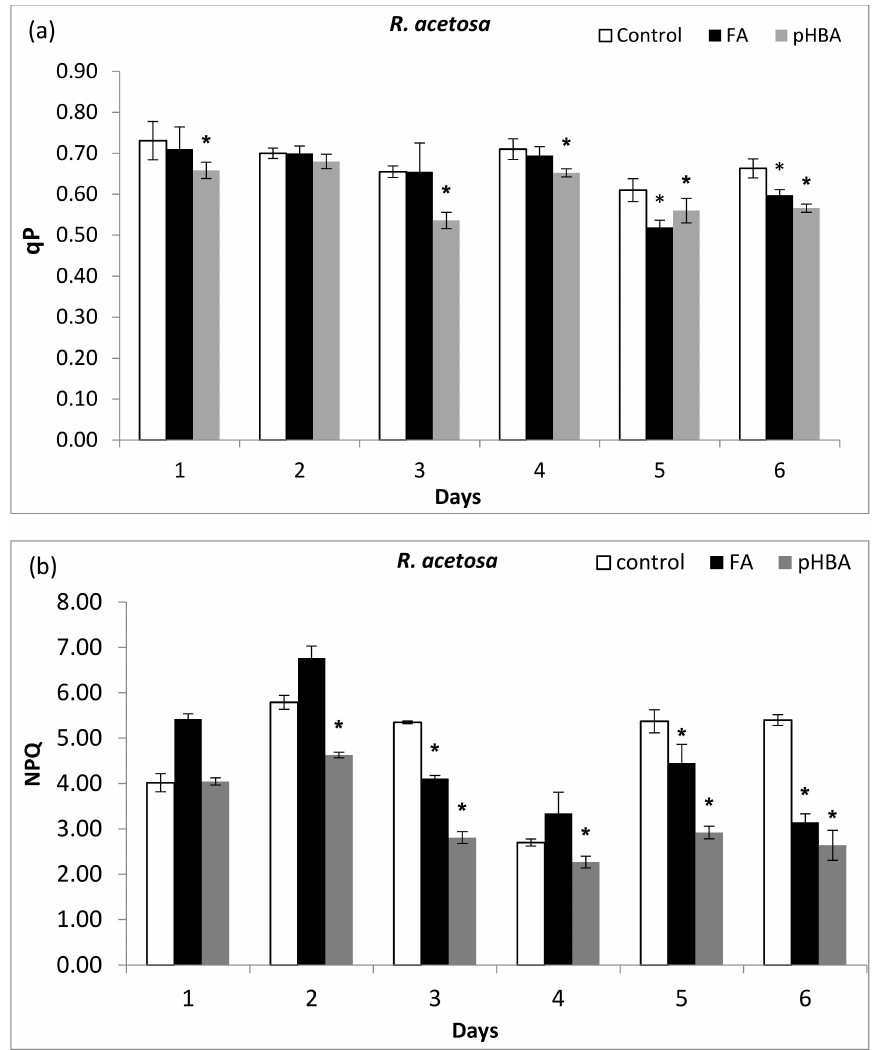
Figure 3. Changes in chlorophyll fluorescence quenching (qP) ( a ) and non-photochemical fluores- cence quenching (NPQ) ( b ) in leaves of Rumex acetosa from days 1 to 6 following exposure to FA and pHBA. Every column in each graph represents the mean ( ± S.E.) of three replicates. * Asterisks indicate significant differences at p ≤ 0.05 with respect to